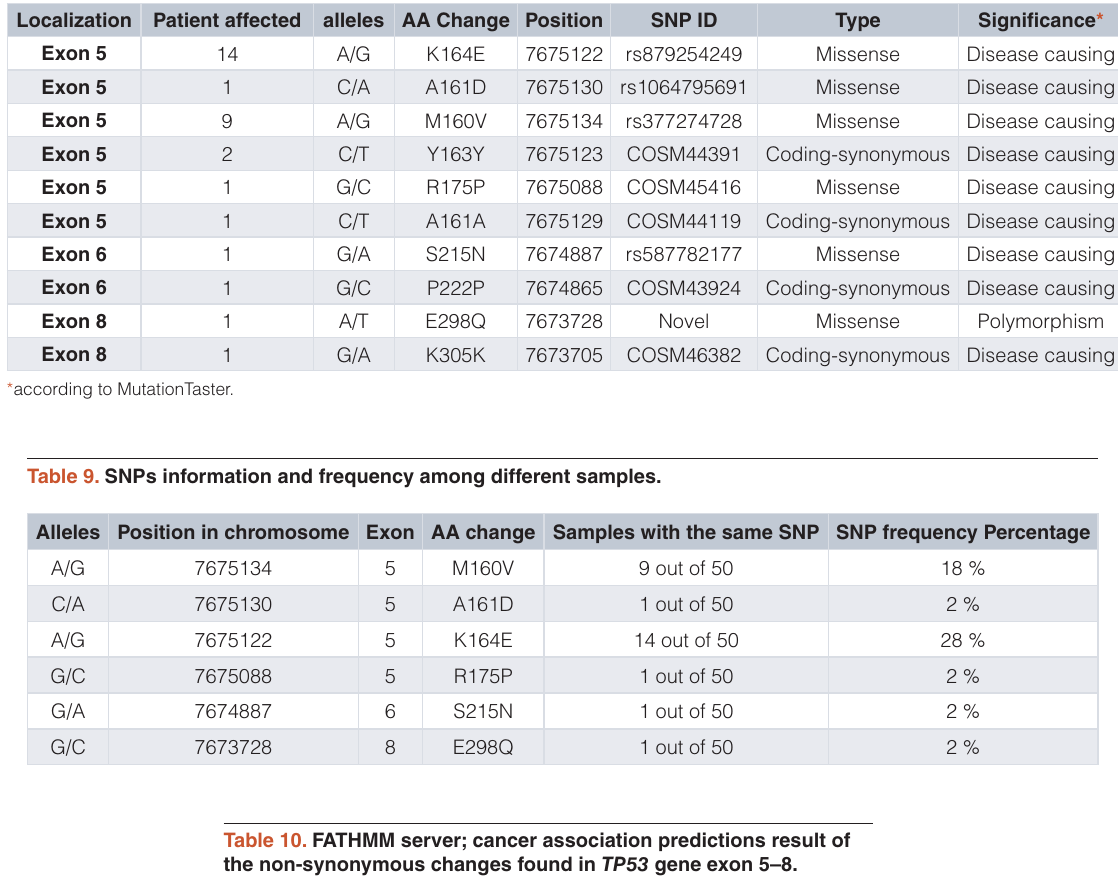
Table 8. Summary of SNP Characteristics identified in TP53 gene exon 5, 6 and 8. Localization Patient affected alleles AA Change Position